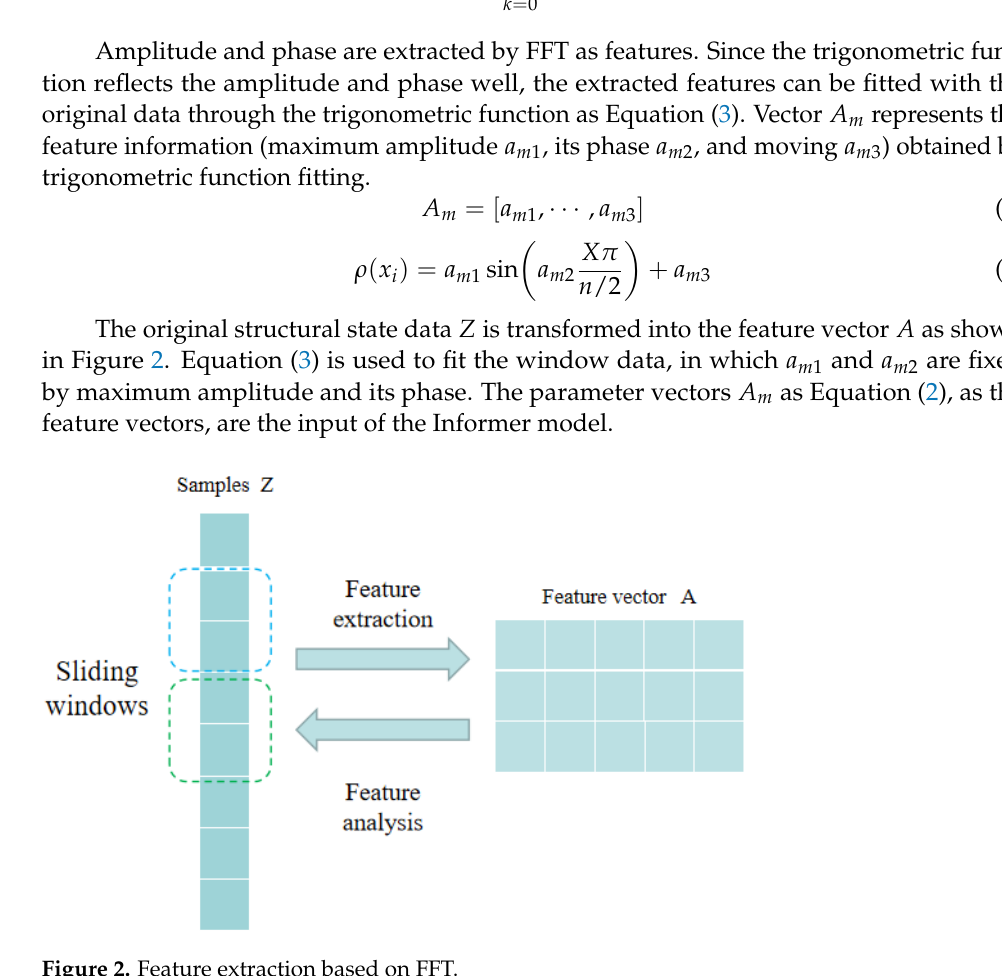
Figure 2. Feature extraction based on